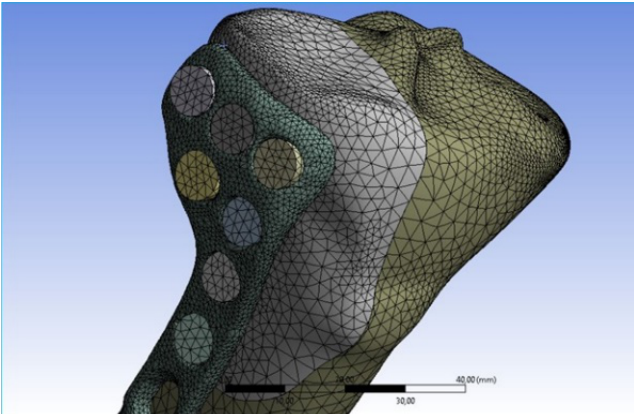
Figure 7. Particulars of the mesh of the proximal tibia.